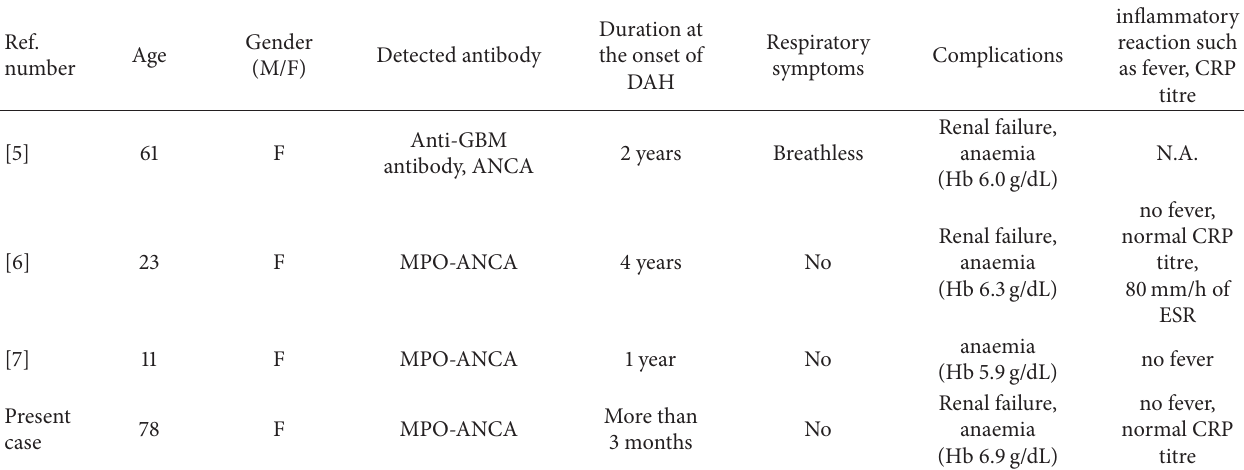
Table 1: Clinical characteristics of cases of chronically progressive DAH with MPA reported in the literature, including the present case.